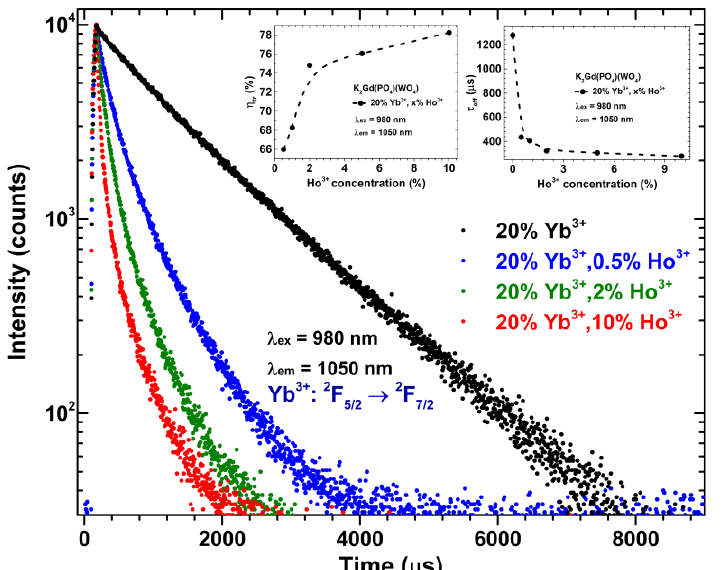
Figure 7. Yb 3+ decay curves of K 2 Gd(PO 4 )(WO 4 ):20%Yb 3+ as a function of Ho 3+ concentration. Inset graphs show the energy transfer efficiency ( η tr ) and τ eff values as a function of Ho 3+ concentration. The temperature-dependent up-conversion emission spectra were recorded in the 77 – 500 K temperature range to evaluate samples’ performance at high temperatures. The temperature-dependent up-conversion emission ( λ ex = 980 nm) spectra of K 2 Gd(PO 4 )(WO 4 ):20%Yb 3+ ,0.5%Ho 3+ sample along with normalized integrated emission and red/green emis- sion ratio are presented in Figure 8a. Ho 3+ emission increases with increasing temperature from 77 to 350 K and then decreases with further temperature increases. However, it should be noted that the integrated UC emission intensity at 500 K is around four times higher than the emission at 77 K. The normalized integrated UC emission intensity reaches a maxi- mum of around 300 K and then decreases. The red/green emission ratio decreases in the temperature range from 77 to 150 K and increases with further temperature increase. This shows that the green emission is quenched faster with increasing temperature compared to the red emission. Such temperature-dependent UC emission spectra feature could be used for luminescent temperature sensing. Moreover, the red/green ratio change is also reflected by a color change from orange-red (at 77 K) to orange (at 300 K) and then to a deep-red region with a further temperature increase to 500 K. The color point shifting could be observed in the CIE1931 color space diagram. All the calculated color points are near the edge of the CIE1931 color space diagram, showing the high color purity of the prepared samples. The exact calculated color coordinates of the prepared samples are tabulated in Table S8.